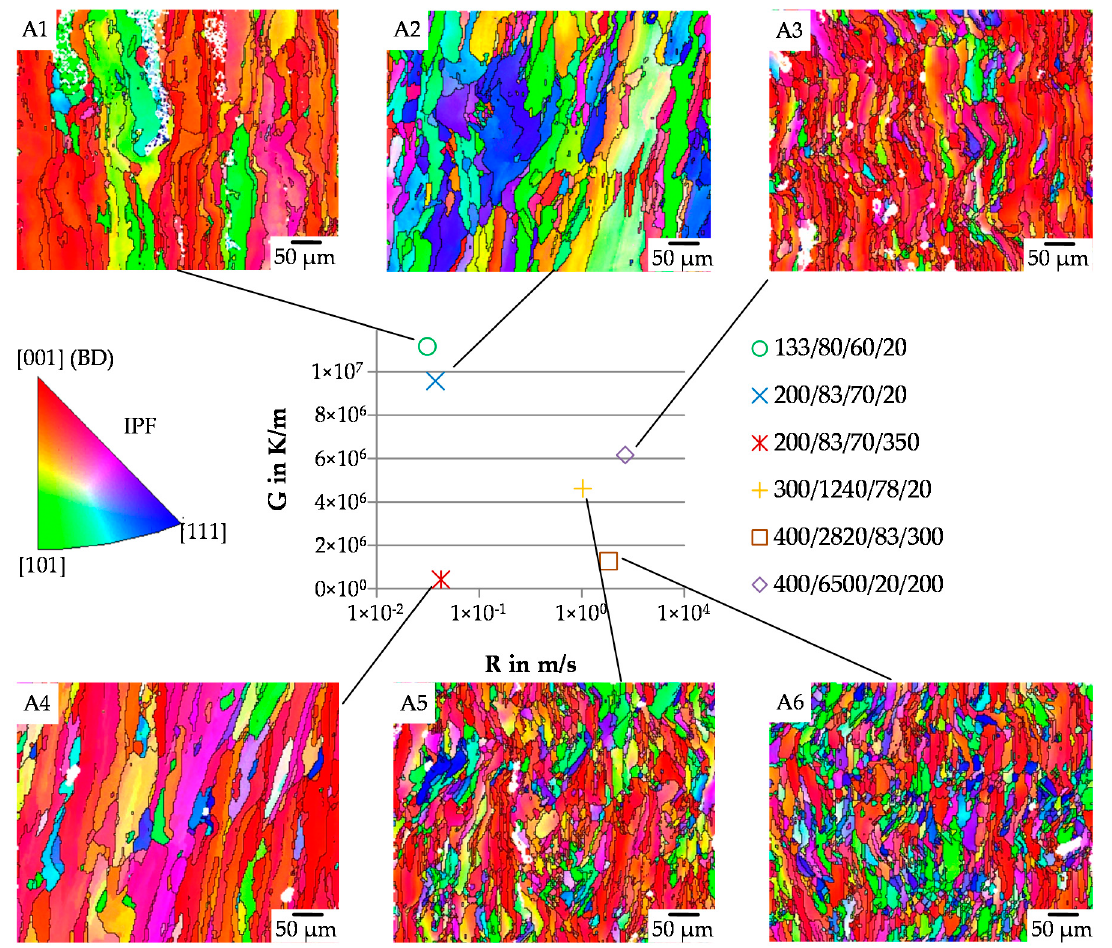
Figure 11. Characteristic grain structure in dependence of G and R. For enlarged EBSD-pictures with included pole-figures see Figures A1–A6. Nomenclature of the legend: (P L / v S ) / ( ∆ y / T pre ). Grain orientation is according to IPF coloring. White regions mark “no detection”.